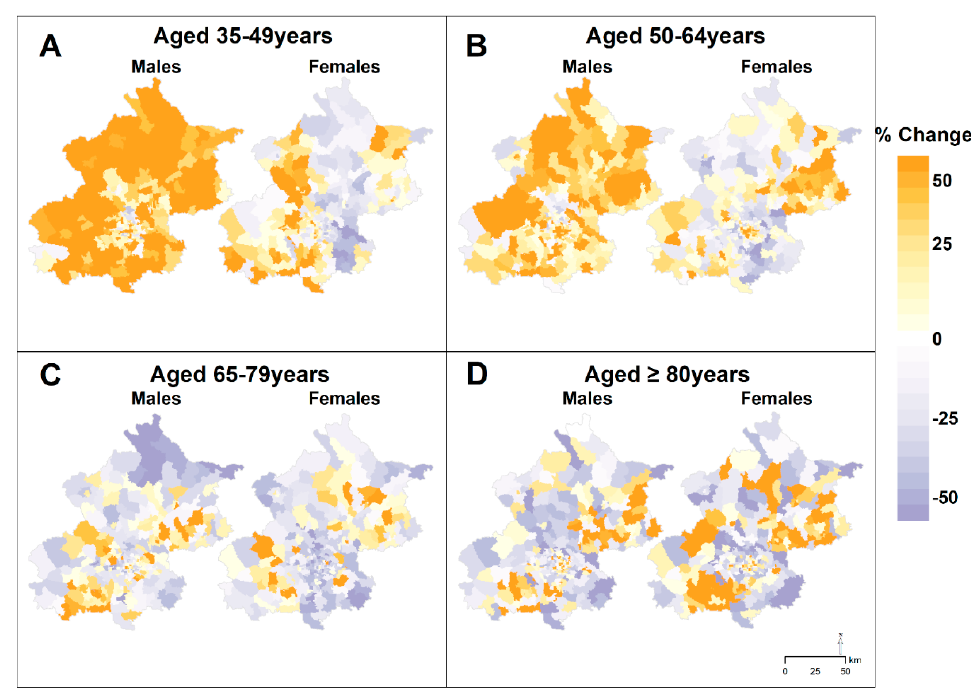
Figure 4. Percentage Changes in the Incidence of Acute Myocardial Infarction by Age − Sex Groups at the Township Level in Beijing, 2007 −